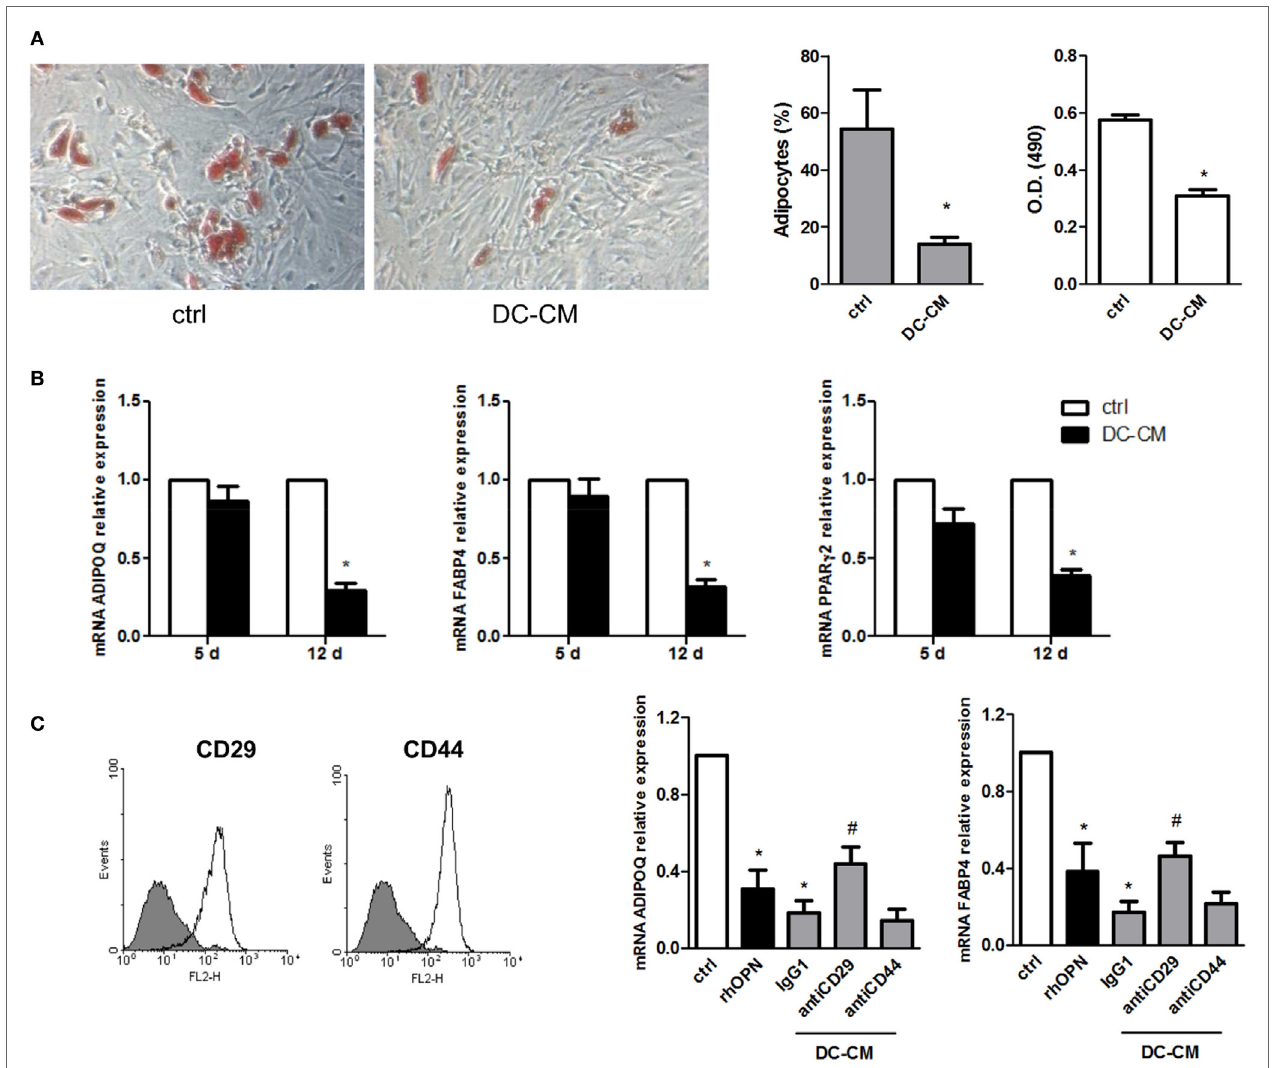
FigUre 3 | DC-conditioned medium inhibits mesenchymal stromal cells (MSC) differentiation into adipocytes through osteopontin release. (a) MSCs were cultured for 15 days in adipocyte differentiation medium in the presence of 30% DC-CM or RPMI (control condition, ctrl) and stained with Oil Red O to reveal lipid droplets (original magnification 5 × ) (left panel). Adipocytes were counted in five random fields from one representative well per group (middle panel) and Oil Red O extracted with isopropanol was measured at optical density 490 (right panel) (mean ± SEM of four independent wells). * p < 0.05 vs. ctrl by Student’s t -test. (B) The mRNA levels of ADIPOQ , FABP4, and PPAR γ 2 were analyzed by real-time PCR at days 5 and 12 of culture. Data were shown as means ± SEM ( n = 3). * p < 0.05 vs. ctrl by Student’s t -test. (c) MSCs were examined for the expression of CD29 and CD44 by flow cytometry (gray area, isotype control; white area, specific antibody). MSCs were induced by adipogenic differentiation medium in control condition, with rhOPN or DC-CM in the presence or the absence of the indicated antibodies. Relative mRNA expression of ADIPOQ and FABP4 was measured by real-time PCR on day 12 of adipogenic induction. RPL13A was used for normalization. Data were shown as means ± SEM ( n = 3). * p < 0.05 vs. ctrl; # p < 0.05 vs DC-CM in presence of the isotype control by one-way ANOVA followed by Tukey’s Multiple Comparison